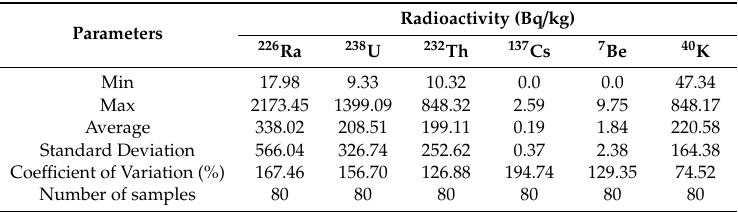
Table 7. Statistic of characterization of radioactivity in the soil.